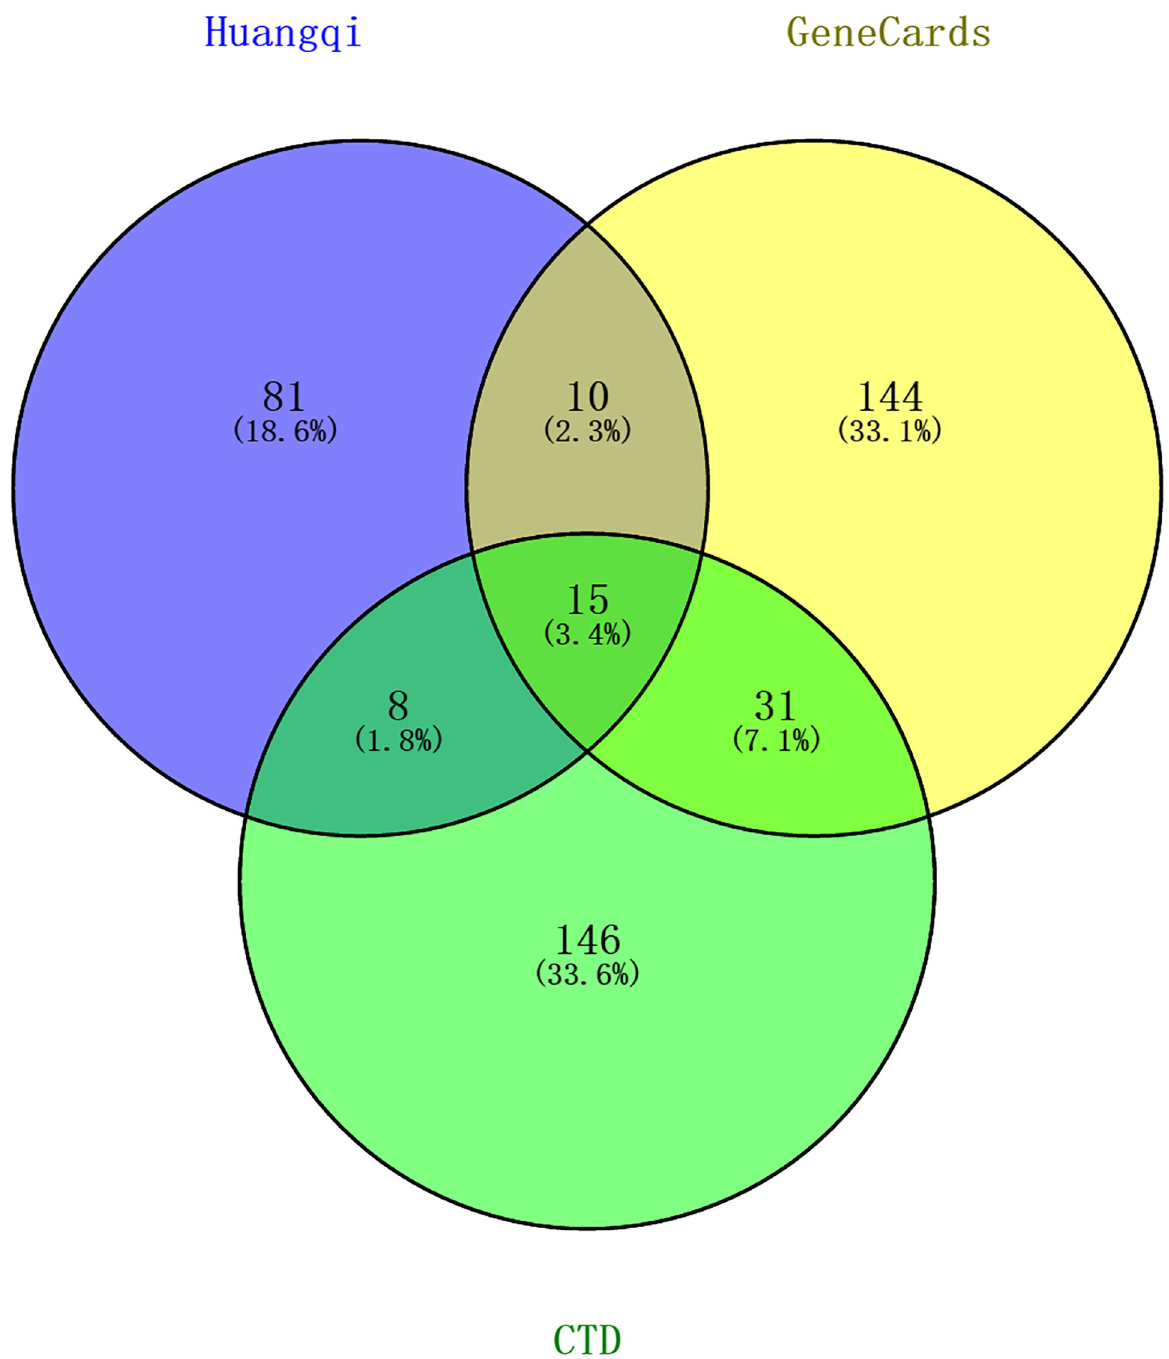
Fig 1. Venny diagram. 33 overlapped target genes were from three databases (TCMSP, CTD and GeneCards).